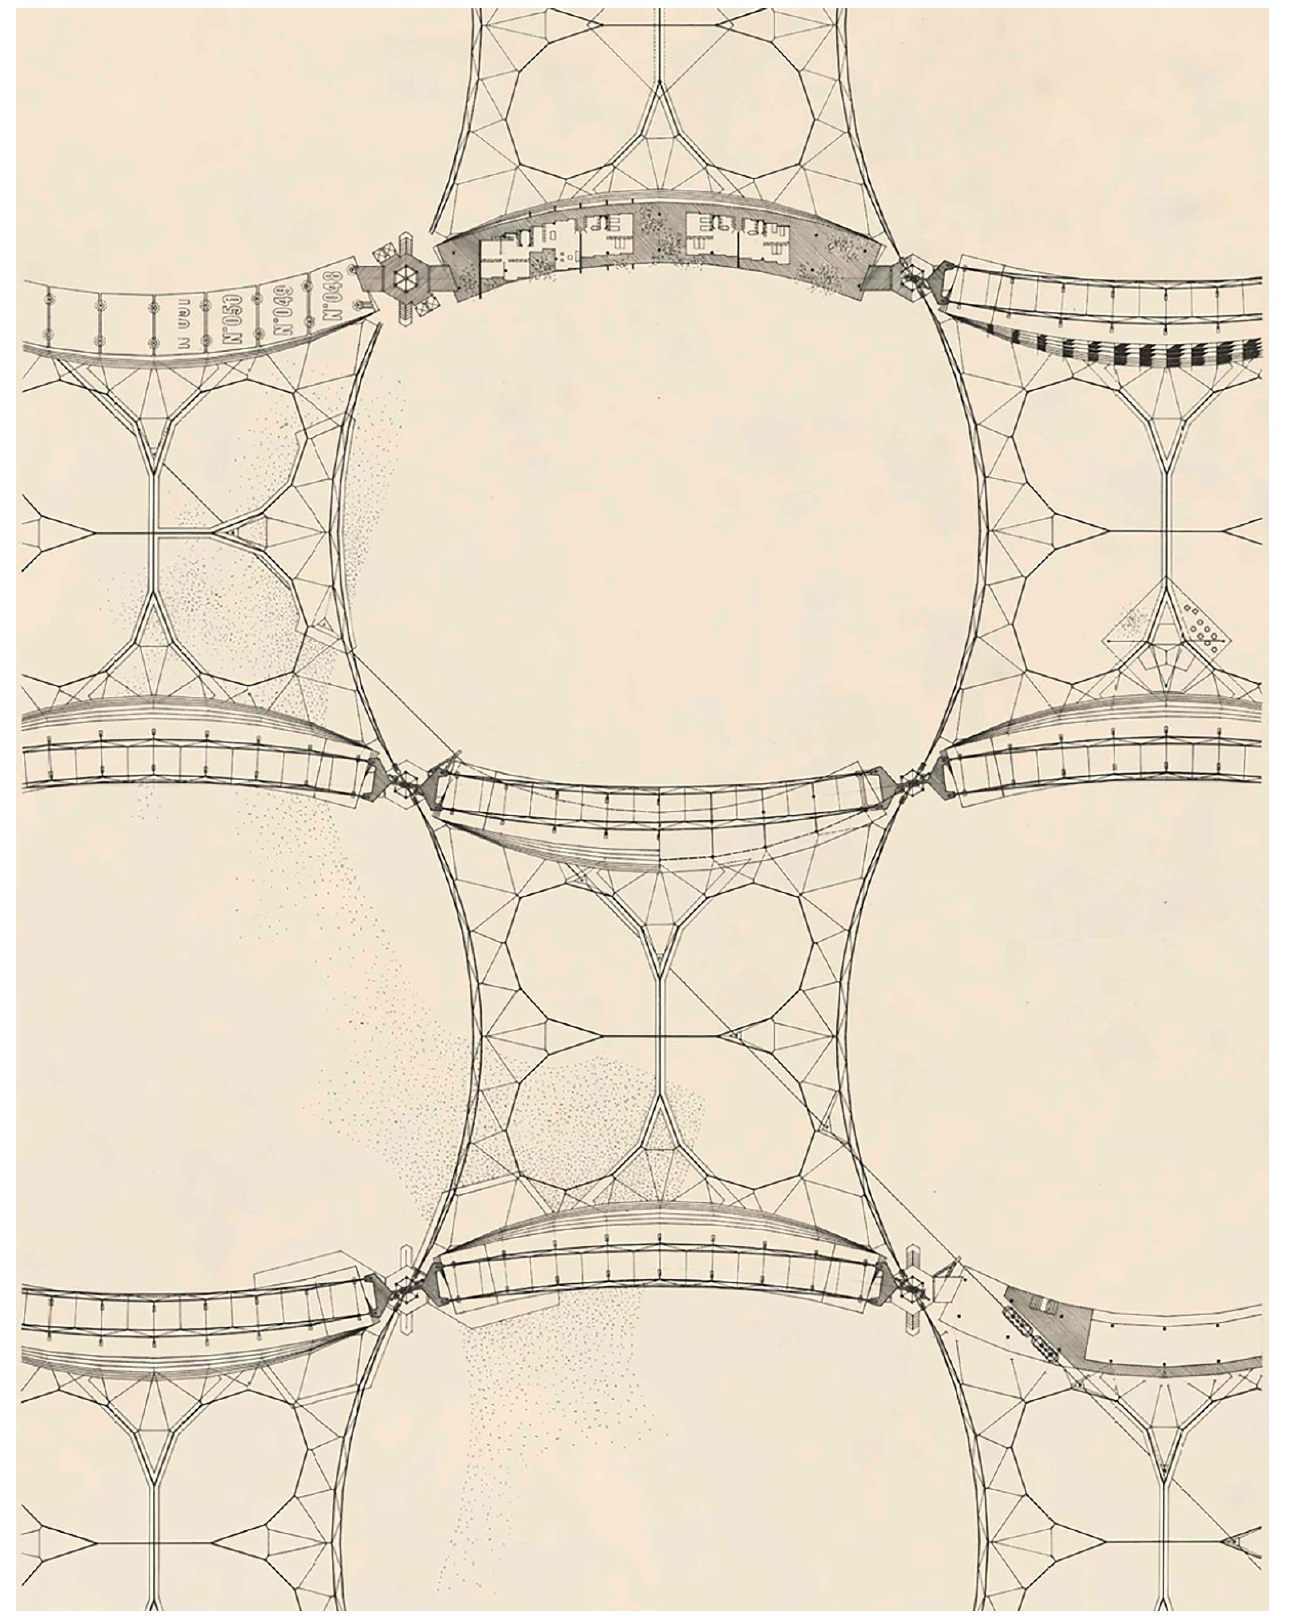
Figure 3. Takis Ch. Zenetos. Plan of the urban grid (1962). “Electronic Urbanism.” Image courtesy of the Takis Ch. Zenetos Archive.